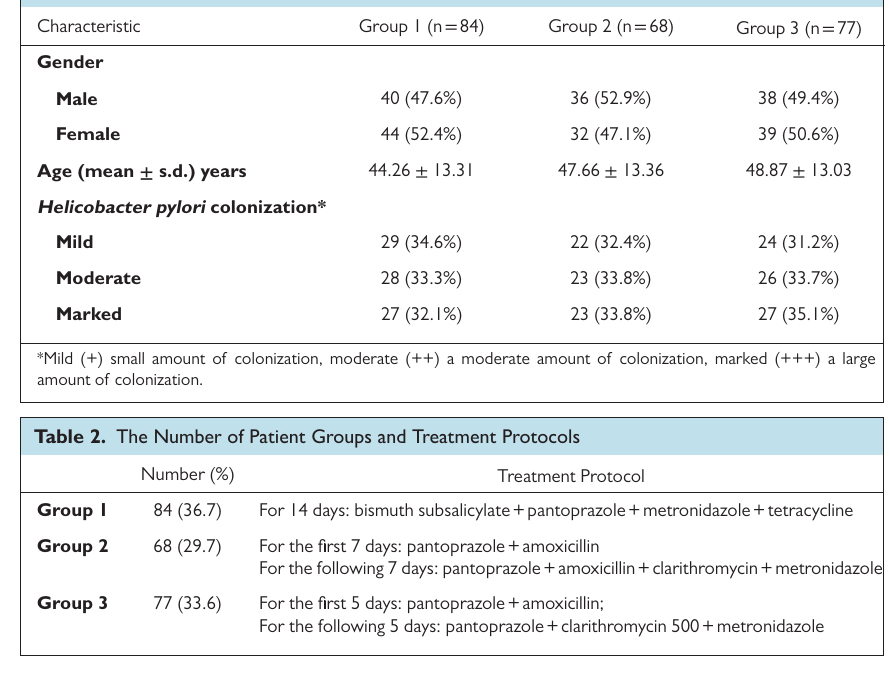
Table 1. Baseline Demographic and Clinical Characteristics of the Patients